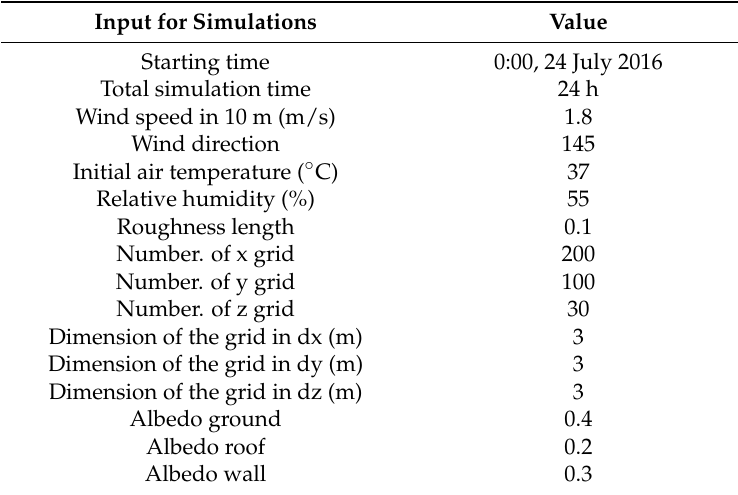
Table 3. Initial simulated data for the simulations.